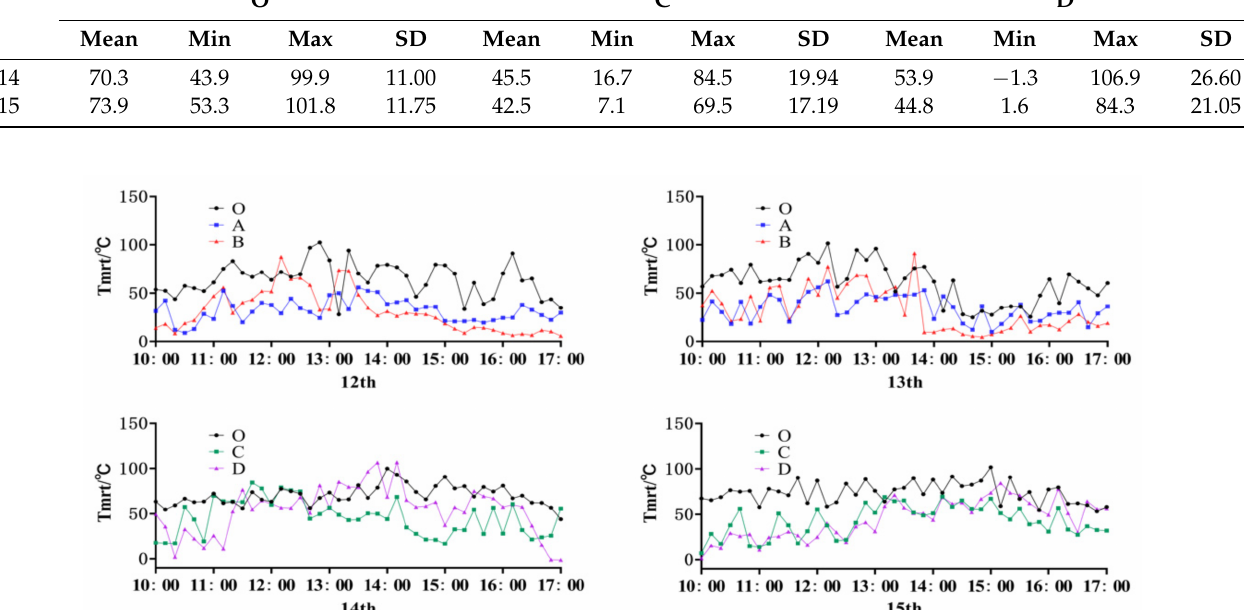
Figure 10. Comparison of Tmrt changes in different